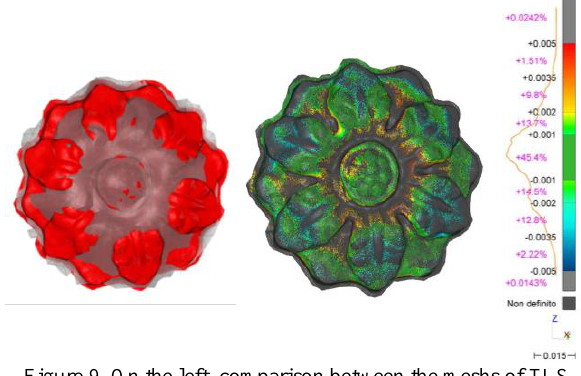
Figure 9. On the left, comparison between the meshs of TLS (grey) and F6 short range (red); on the right, distance computation.